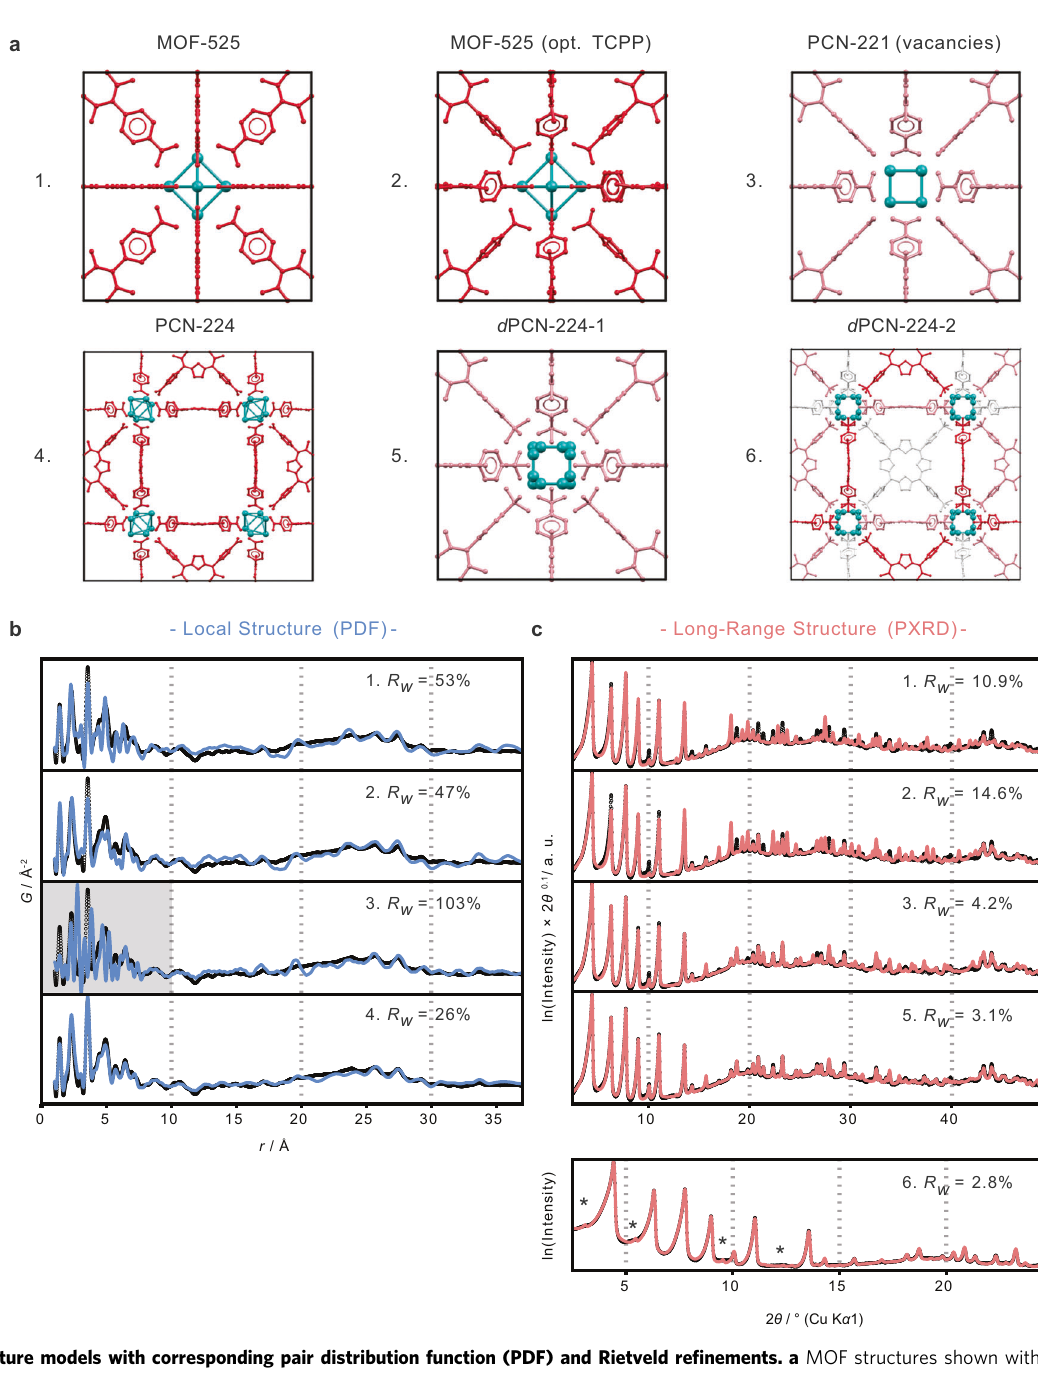
Fig. 5 Structure models with corresponding pair distribution function (PDF) and Rietveld re fi nements. a MOF structures shown with Zr (teal) and tetrakis(4-carboxyphenyl)porphyrin (TCPP) linkers with 100% (red), 50% (pink), and 0% (gray) occupancy: (1) MOF-525 with planar TCPP linkers and no vacancies, (2) MOF-525 structure with twisted phenyl rings in the TCPP linker and no linker vacancies, (3) PCN-221 (Zr 8 clusters) with equally distributed linker vacancies, (4) PCN-224 structure with ordered TCPP vacancies, (5) d PCN-224-1 built of Zr 6 clusters with four different orientations and equally distributed linker vacancies, and (6) d PCN-224-2 with relative cluster orientations and linker occupation re fi ned separately for each individual linker and cluster site, allowing for different possible local environments (the linker colors of (6) are an artistic representation and not speci fi c to occupancies of the re fi ned model). b PDF fi ts compared to experimental d PCN-224 (blue, PDF of MOF_ZrOCl 2 measured using synchrotron radiation), showing poor agreement between the local environments in structures 1 – 3 and good agreement with the local structure of PCN-224 (structure 4). c Improvement of the Rietveld re fi nements of experimental d PCN-224 (pink, also sample MOF_ZrOCl 2 ) for models shown. The extra intensities generated by the 2 × 2 × 2 supercell model of d PCN-224 are highlighted (*). Rw is the residual value (see Supplementary Information “ Pair distribution function analysis ”